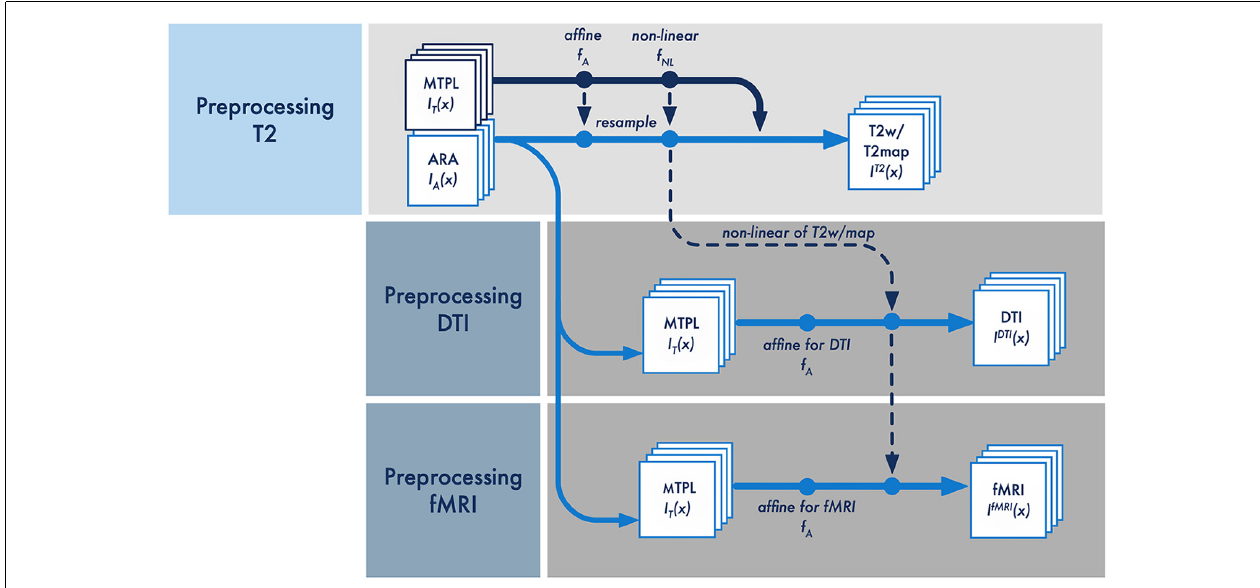
FIGURE 4 | Schematic overview of the multi-step registration procedure for the T2-weighted, DTI and rs-fMRI data [ I T 2 ( x ), I DTI ( x ) and I fMRI ( x )]. The affine f A and non-linear transformation f NL is applied to MRI template (MTPL) I T ( x ) and subsequently the ARA I A ( x ) with the pre-processed data set I T 2 ( x ). The non-linear deformation f NL between MTPL and the T2w/T2m is calculated only once and then linked to the respective affine transformation to pre-processed data of DTI I DTI ( x ) and rs-fMRI I fMRI ( x ).